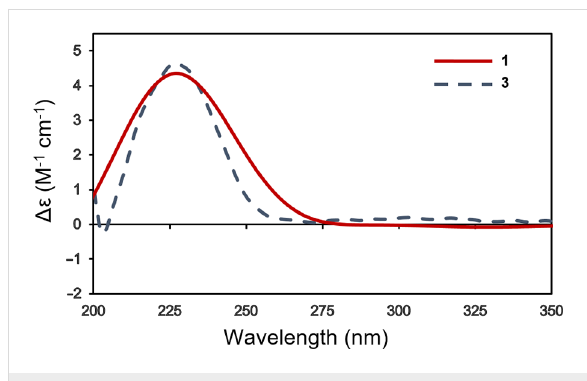
Figure 3: ECD spectra of compounds 1 and 3 in MeOH.